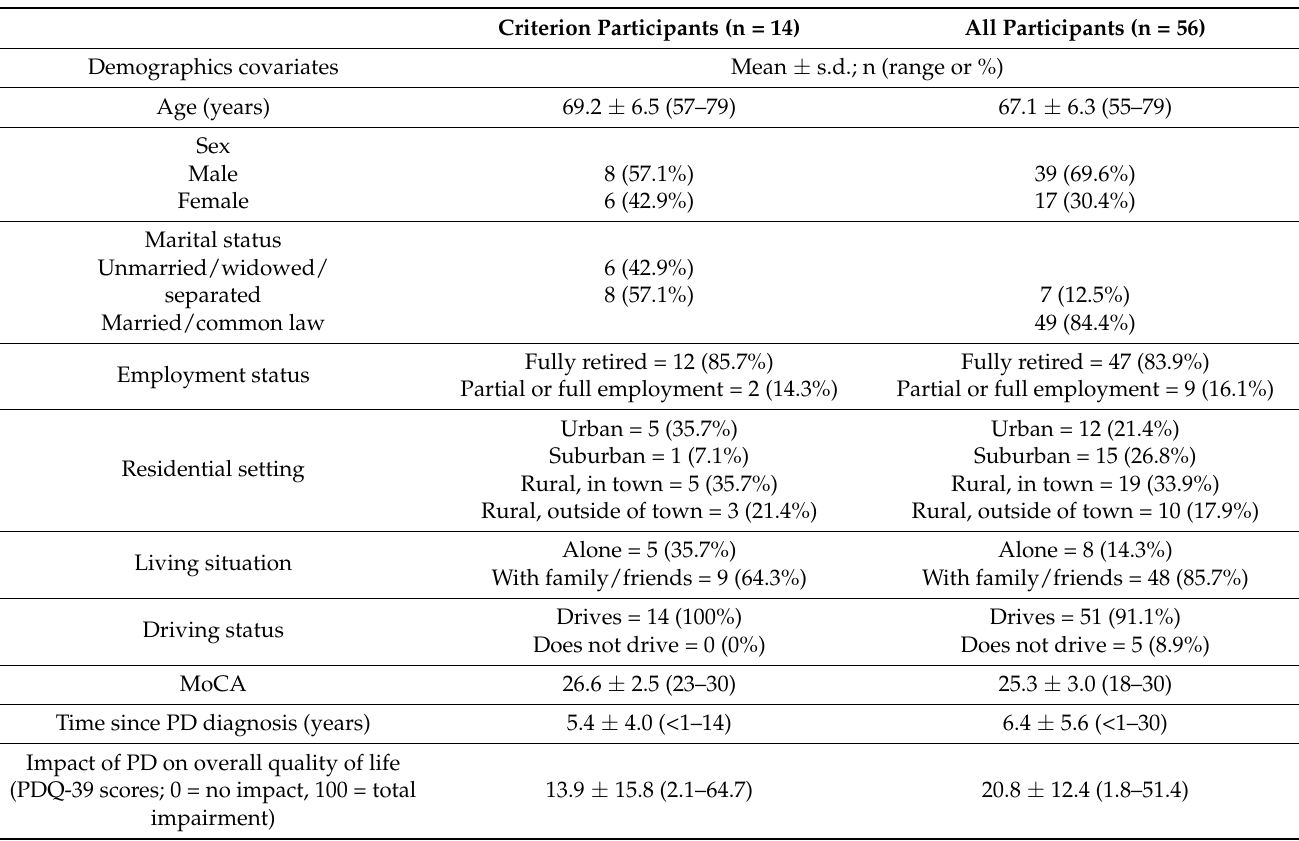
Table 1. Demographic characteristics of the selected criterion participants compared to all participants. (PD = Parkinson’s disease; MoCA = Montreal Cognitive Assessment; PDQ-39 = Parkinson’s Disease Questionnaire—39 items; s.d. = standard deviation).